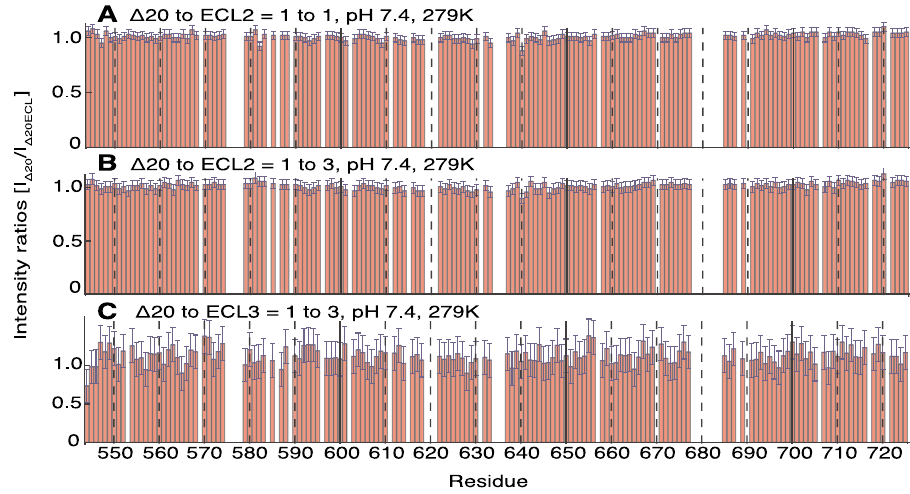
Fig 6. Intensity ratiosbetween Nogo-A- Δ 20 in the presencevs. absenceof ECLs. A : 1 to 1 ratio (ECL2) at pH 7.4 and 6°C. B : 1 to 3 ratio (ECL2)at pH 7.4 and 6°C. C : 1 to 3 ratio (ECL3)at pH 7.4 and 6°C. The values are correctedfor the volume decreaseupon ligand titration.Minordeviations from1 can be explained by imperfectly tuned pH and temperature. Errorbars were calculatedusing Gaussianerrorpropagation.